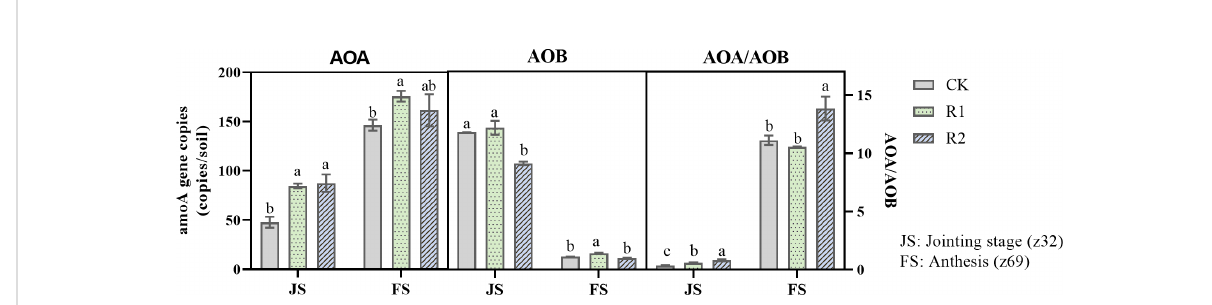
FIGURE 2 Abundances of ammonia-oxidizing bacteria and ammonia-oxidizing archaea in soil under different treatments in 2016 – 2017. AOA, ammonia- oxidizing archaea; AOB, ammonia-oxidizing bacteria; AOA/AOB, the ratio of ammonia-oxidizing archaea and ammonia-oxidizing bacteria; CK, uniform planting (20 cm); R1, wide-narrow row planting (12 cm-12 cm-12 cm-24 cm); R2, narrow uniform planting (12 cm). Different letters indicate signi fi cant differences among row spacing mode at the P < 0.05